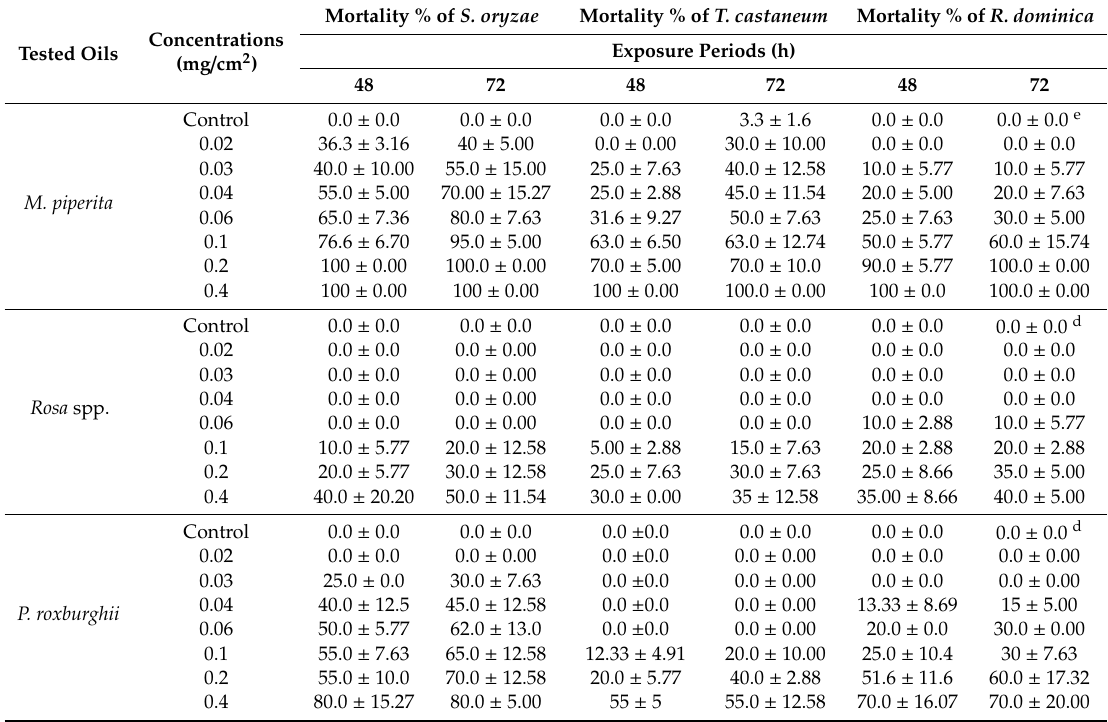
Table 5. Mortality percentage and toxicities of S. oryzae, T. castaneum , and R. dominica treated using M. piperita , Rosa spp., and P. roxburghii as the contact methods.